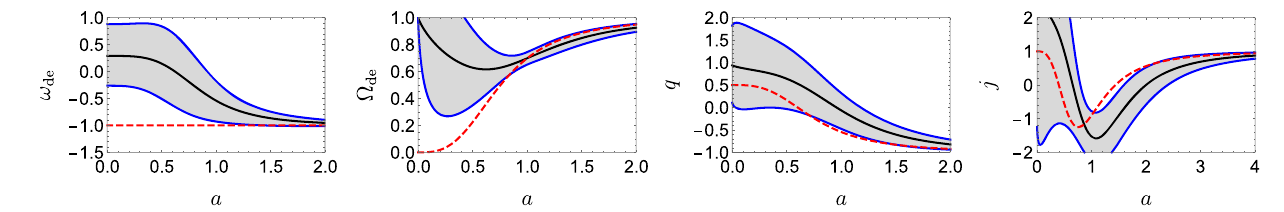
The shaded region and blue lines represent the 1 σ level regions and corresponding boundaries in the GP